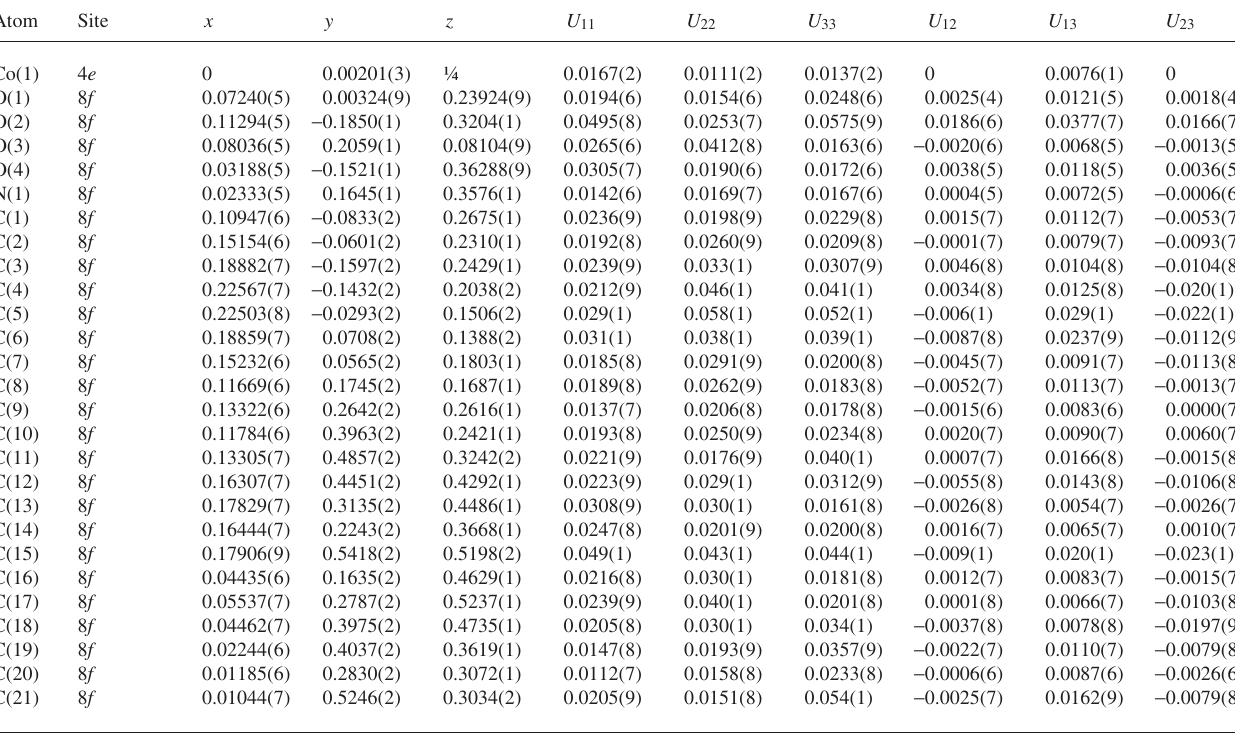
Table 3. Atomic coordinates and displacement parameters (in Å 2 )